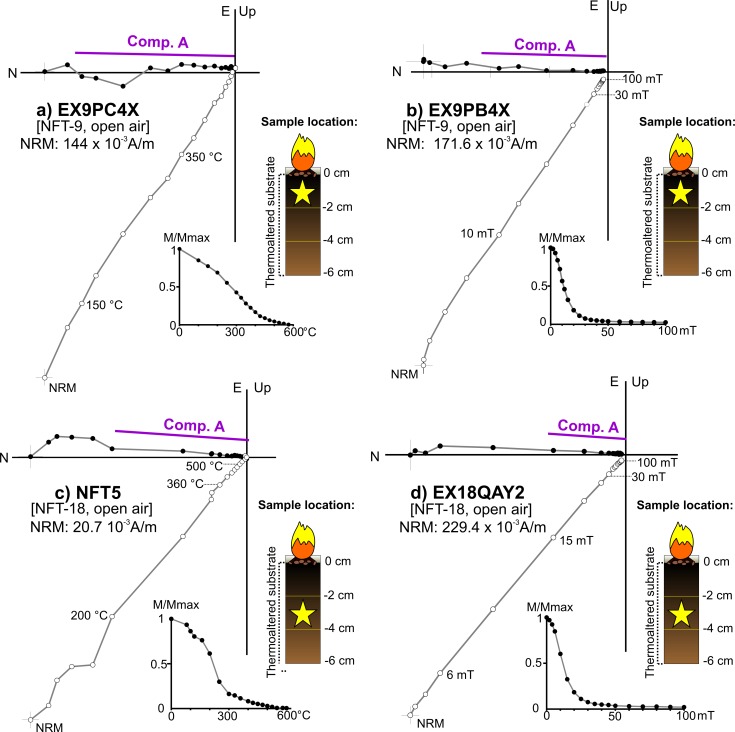
Representative orthogonal NRM thermal and alternating field demagnetizations plots of samples showing component A.(A-B) Superficial specimens; (C-D) intermediate specimens. Symbols as in Fig 7.